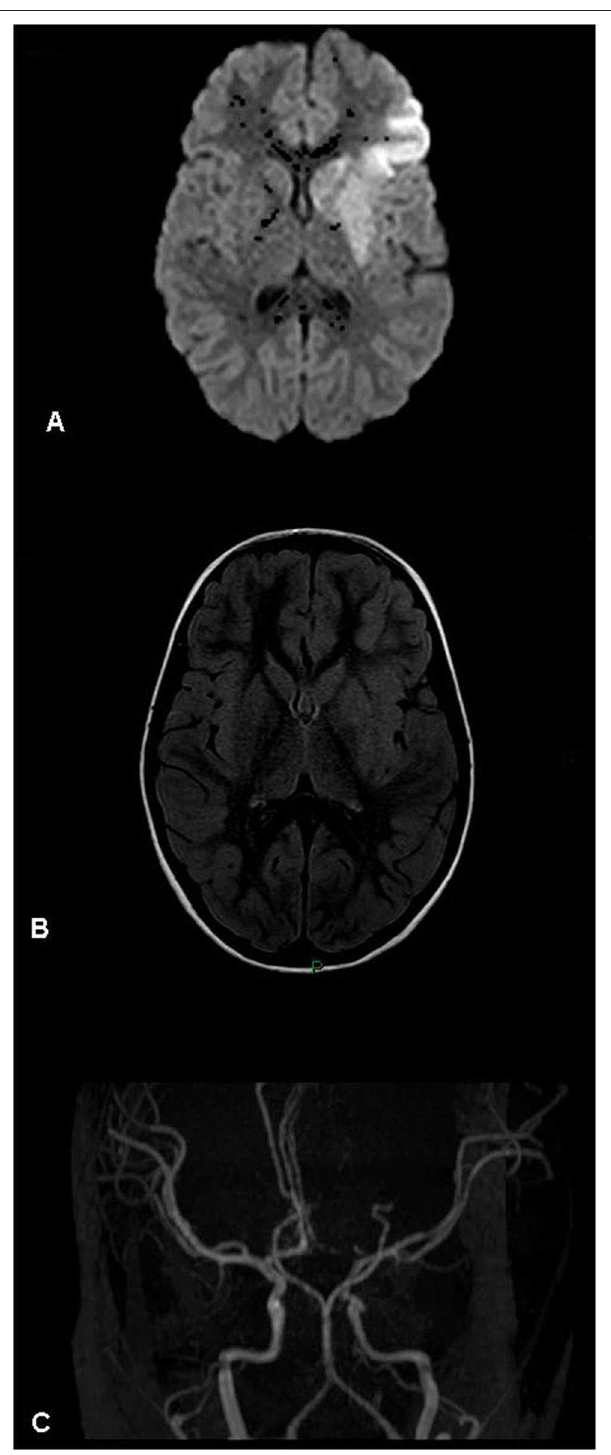
FIGURE 2 | Acute left basal ganglia infarct – magnetic resonance (MR) findings (patient 10, Table 1 ). (A) Diffusion weighted image. (B) MR FLAIR. (C) MR angiogram (3D-TOF). Left basal ganglia and perisylvian acute stroke visualized mostly on diffusion weighted imaging. No mass effect. The angiogram shows an atretic left A1 segment (anatomic variant). No evidence of arterial occlusion. Left M2 segment focal narrowing is